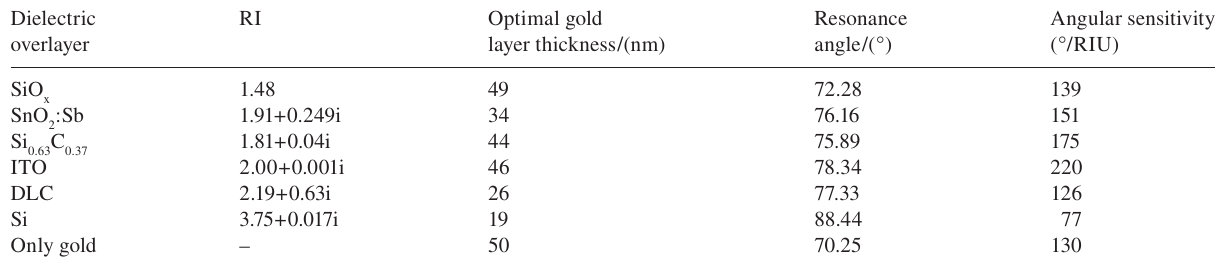
Table 1 Considered dielectric overlayers with their respective refractive indexes and theoretically calculated angular sensitivity when a 10 nm thick top dielectric layer was deposited onto an optimized gold fi lm.